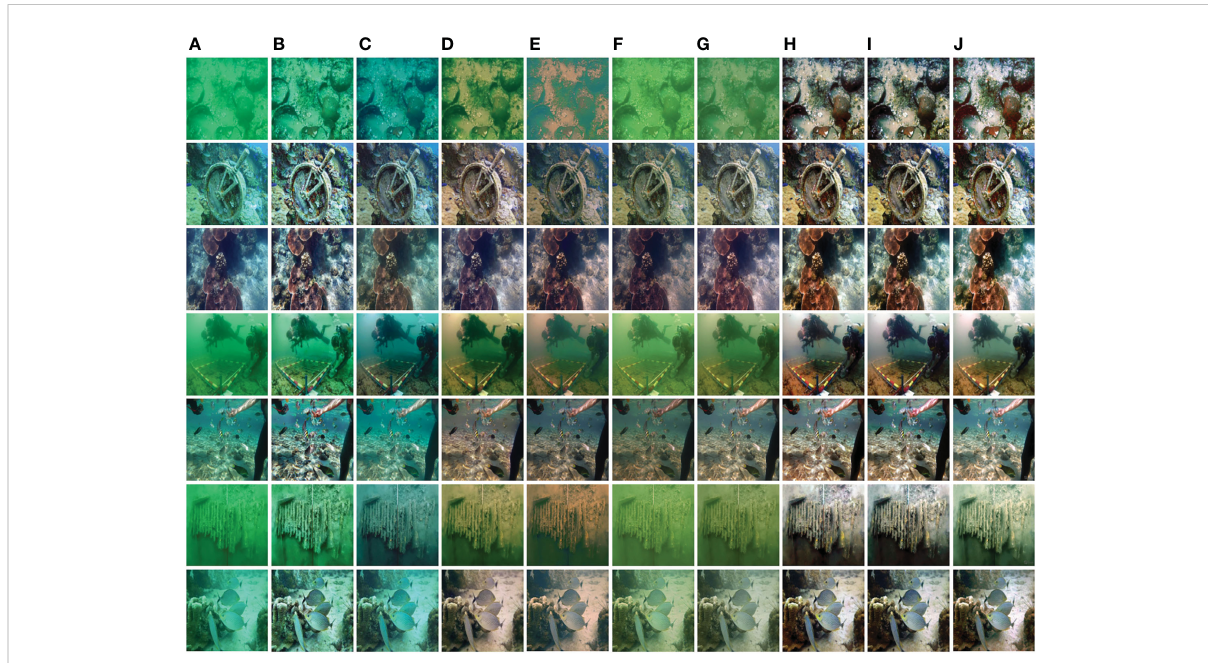
FIGURE 6 Visual comparisons on the UIEB dataset. From left to right, (A) shows the raw underwater images, (B – I) are the results of CLAHE (Pizer et al., 1990), OMGD (Ren et al., 2021), FUnIE-GAN (Islam et al., 2020), WaterNet (Li et al., 2019), UWCNN (Li et al., 2020), Shallow-UWnet (Naik et al., 2021), Spiral-GAN (Han et al., 2020) and the proposed model, respectively, and (J) shows the reference